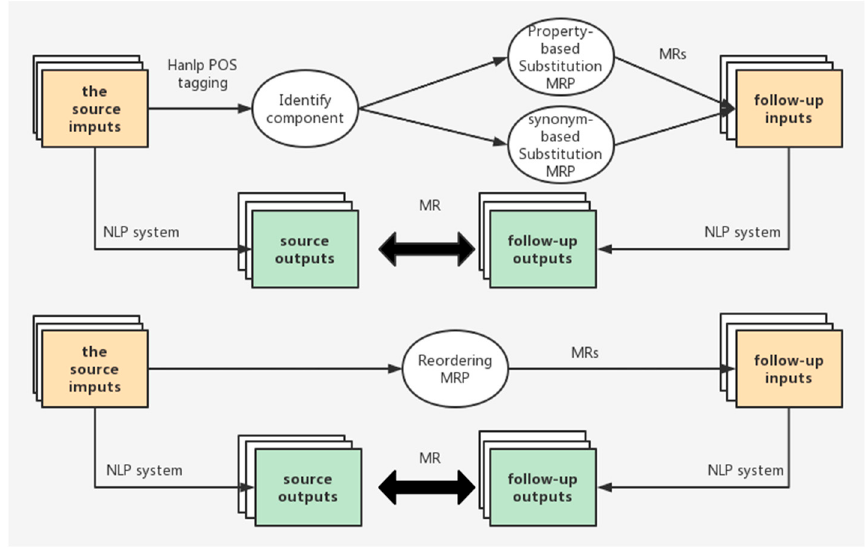
Figure 4. MRs realization